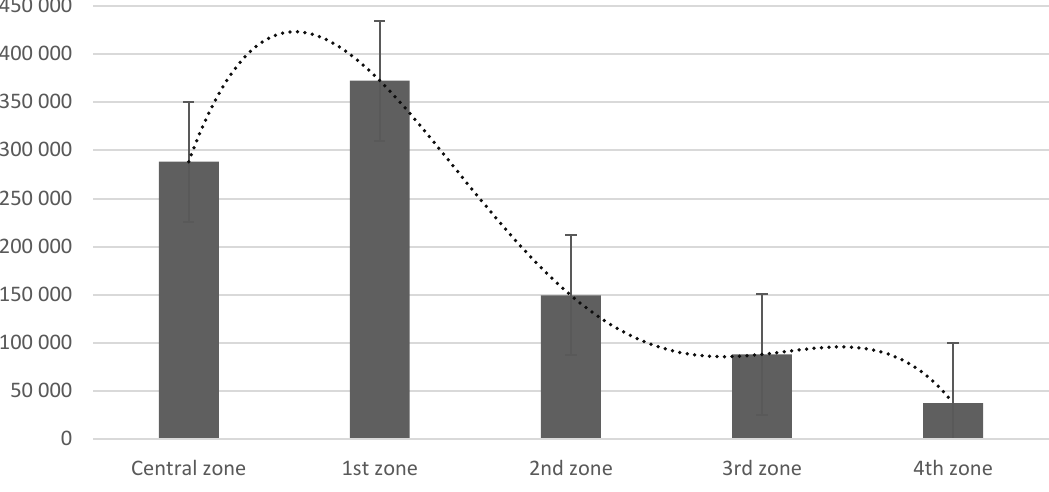
Figure 2. The number of employed in the Ekaterinburg city economy in terms of spatial zones,